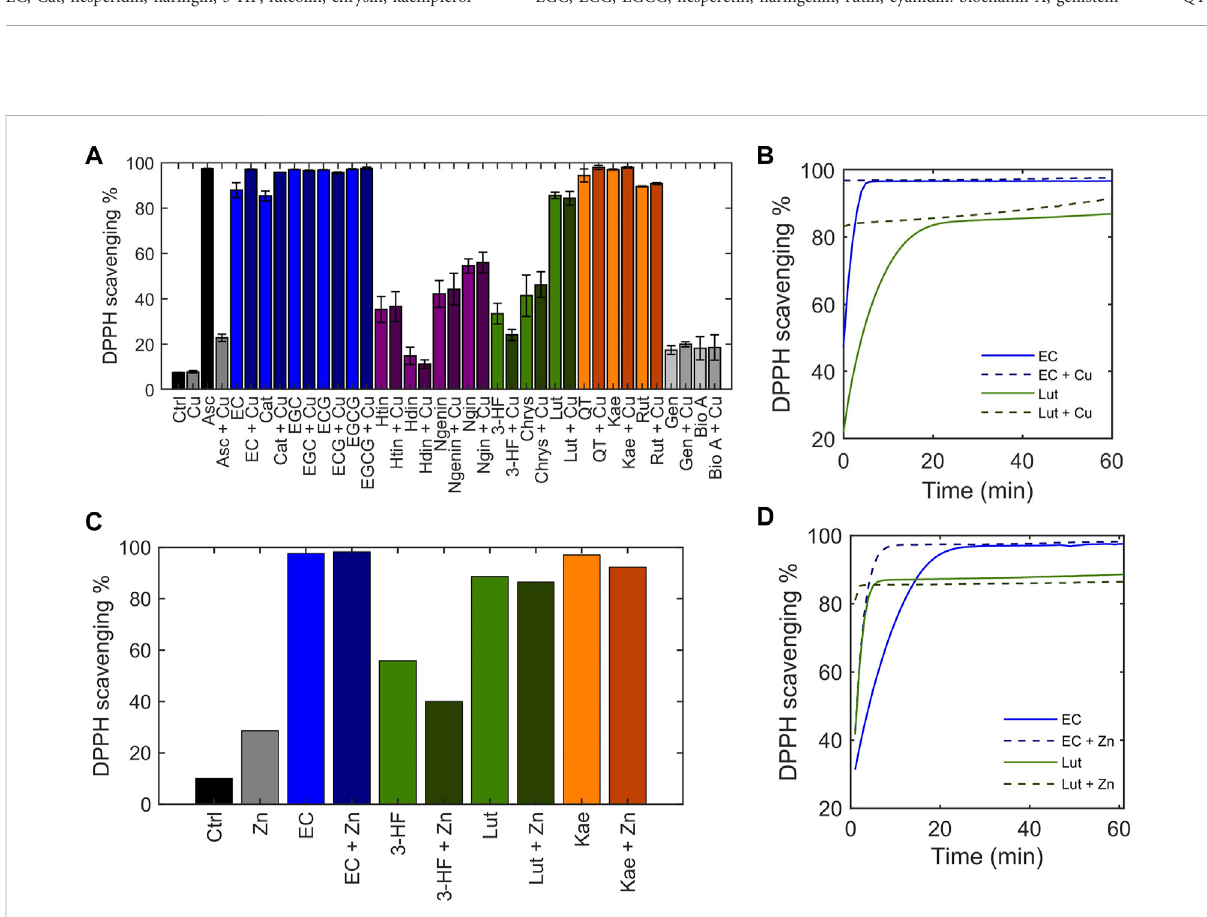
FIGURE 6 Determination of the ability of fl avonoids to scavenge the DPPH radical, depicted as DPPH scavenging %. 50 μ M fl avonoid or ascorbic acid was (cid:129) . (A) The DPPH scavenging % was determined using the 515 nm absorbance of DPPH incubated with 50 μ M CuSO 4 before addition of 50 μ M DPPH at the end of a 1-h reaction. (B) Time-dependent scavenging activity of representative fl avonoids EC and luteolin in the presence of 50 μ M CuSO 4 measured over the course of 1 hour. (C) End-point DPPH scavenging % of fl avonoids in the presence of 50 μ M ZnCl 2 after a 1-h reaction. (D) Time-dependent DPPH scavenging activity of representative fl avonoids EC and luteolin in the presence of 50 μ M ZnCl 2 measured over 1